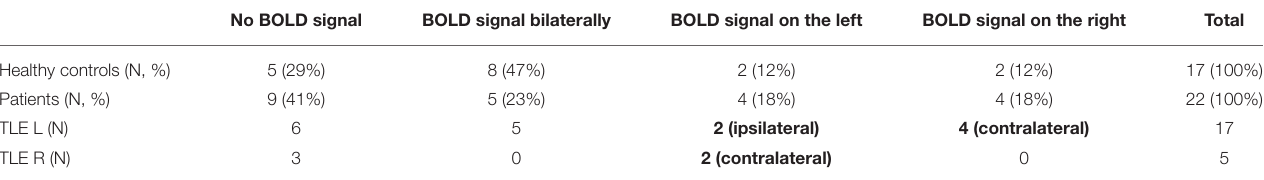
TABLE 3 | fMRI activation patterns in TLE patients and healthy controls.